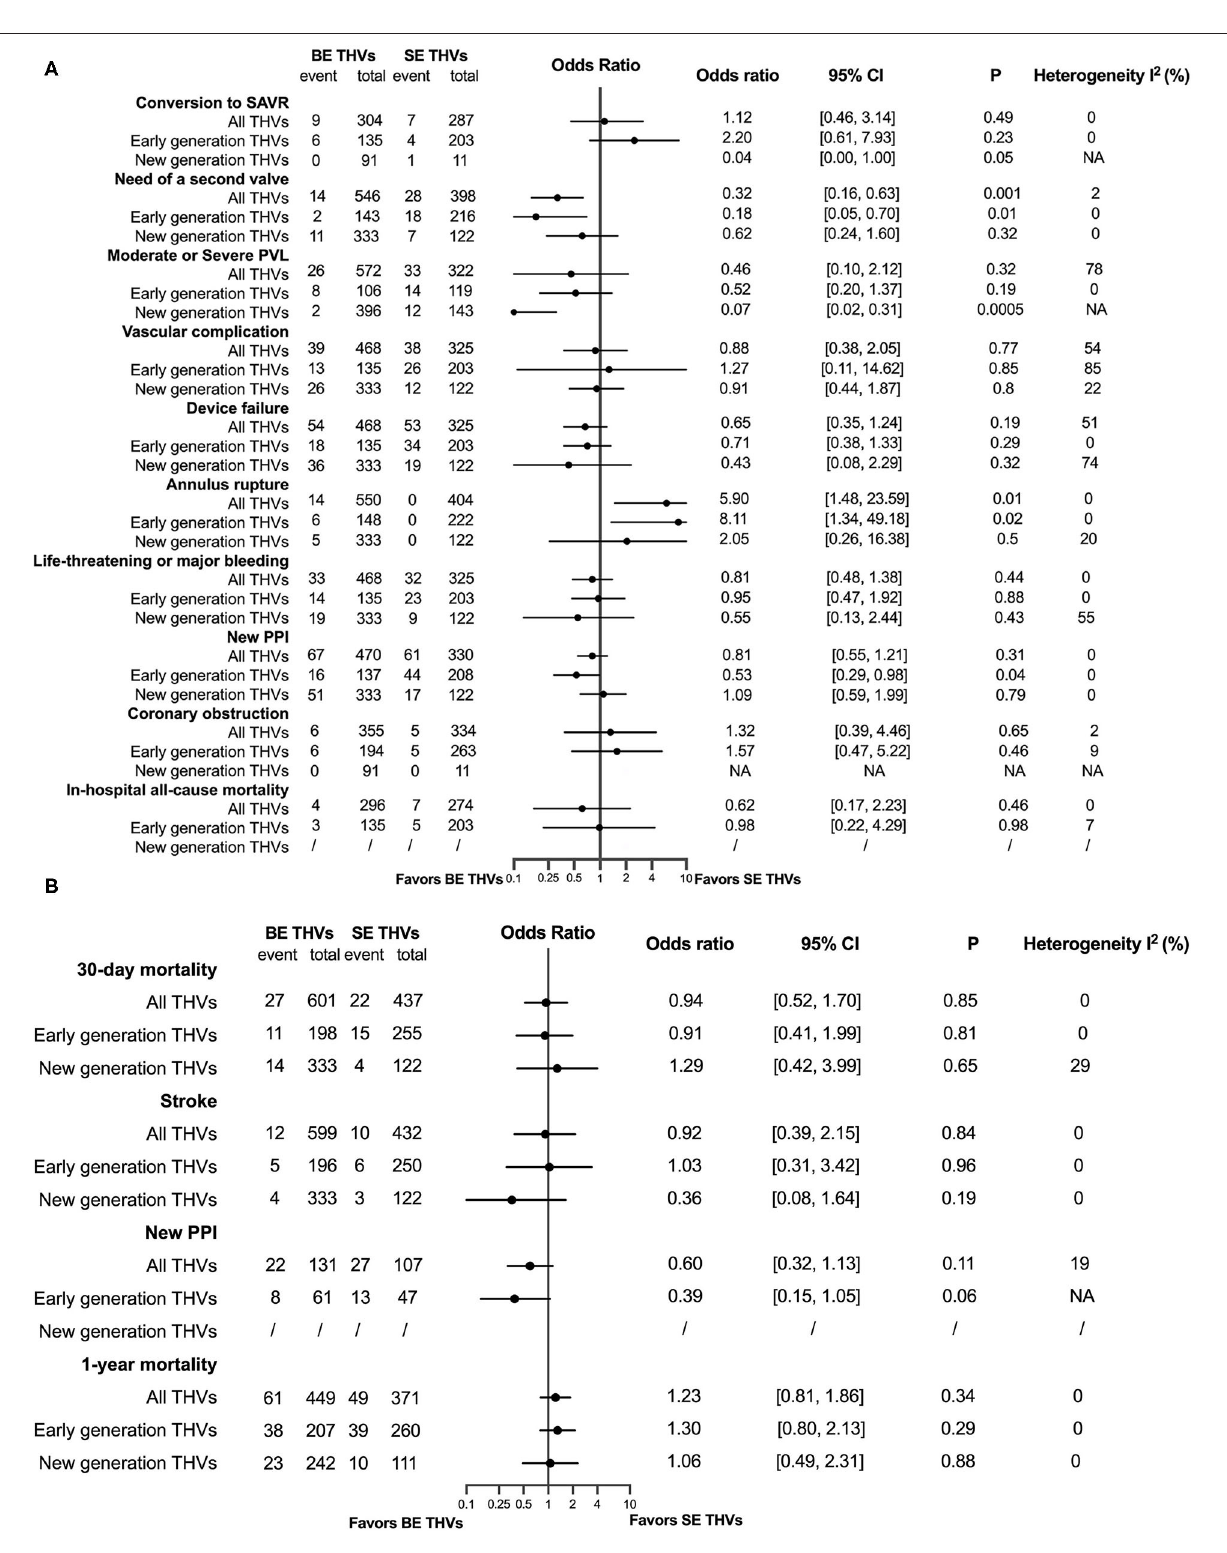
Frontiers in Cardiovascular Medicine |